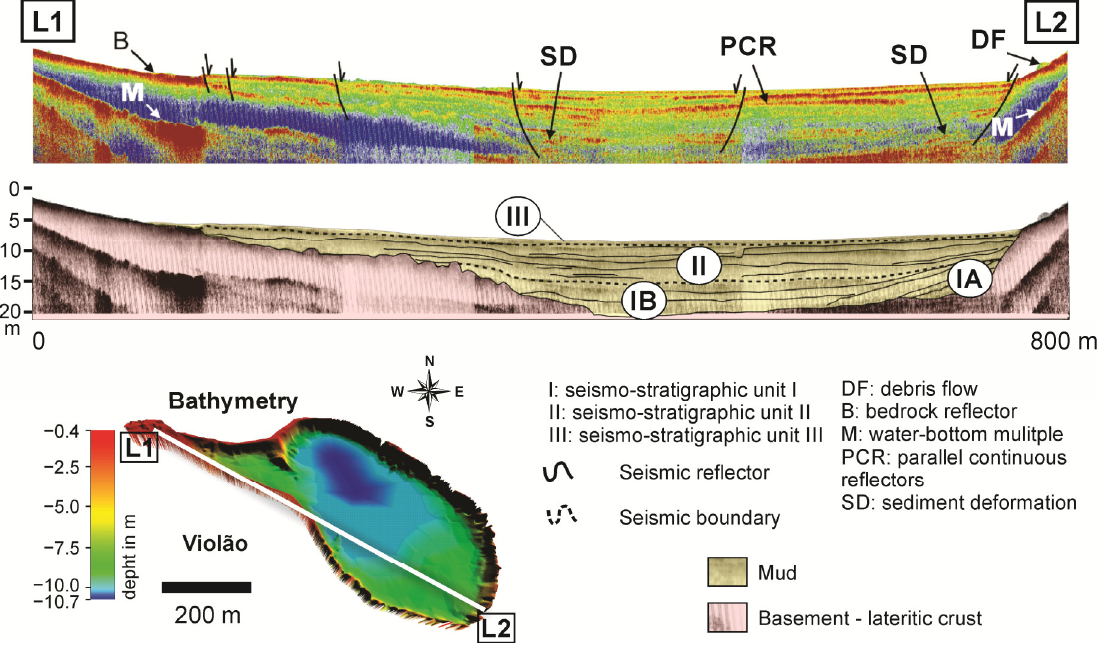
Figure 2. NW–SE longitudinal seismic transects showing the different observed morphologic levels, depositional units, basement and multiple reflectors, and fault. The seismostratigraphic interpretation in the lower part of the figure. All interpreted units can be accessed elsewhere [3]. Upper figure (shallow seismic image), middle figure (seismostratigraphic interpretation) and lower figure (legends and location of the seismic profile in the lake bathymetry).